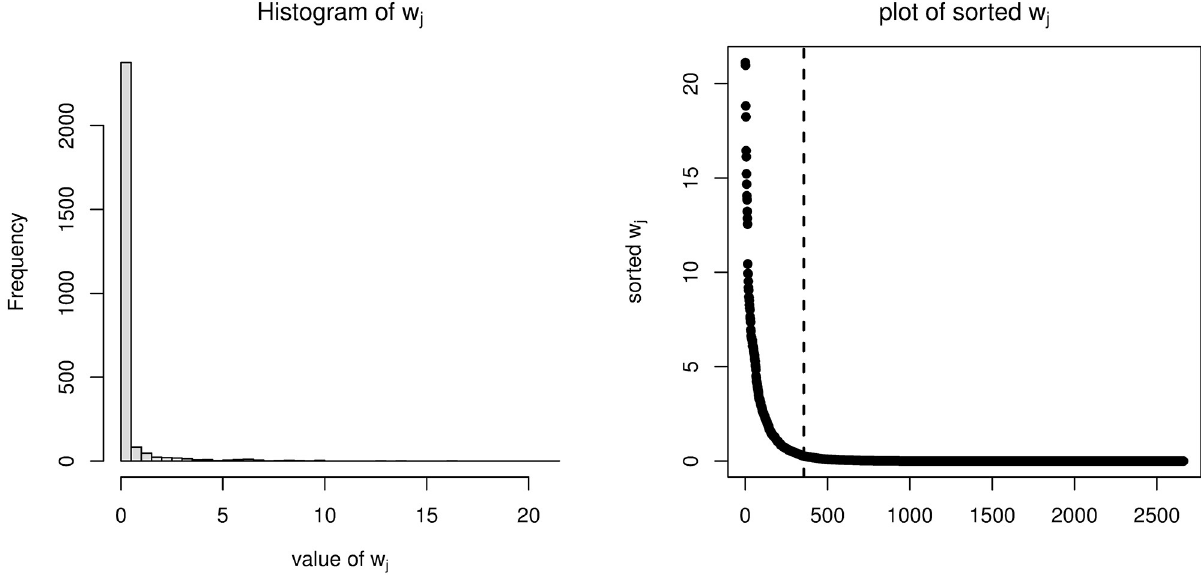
Fig 1. Histogram of w